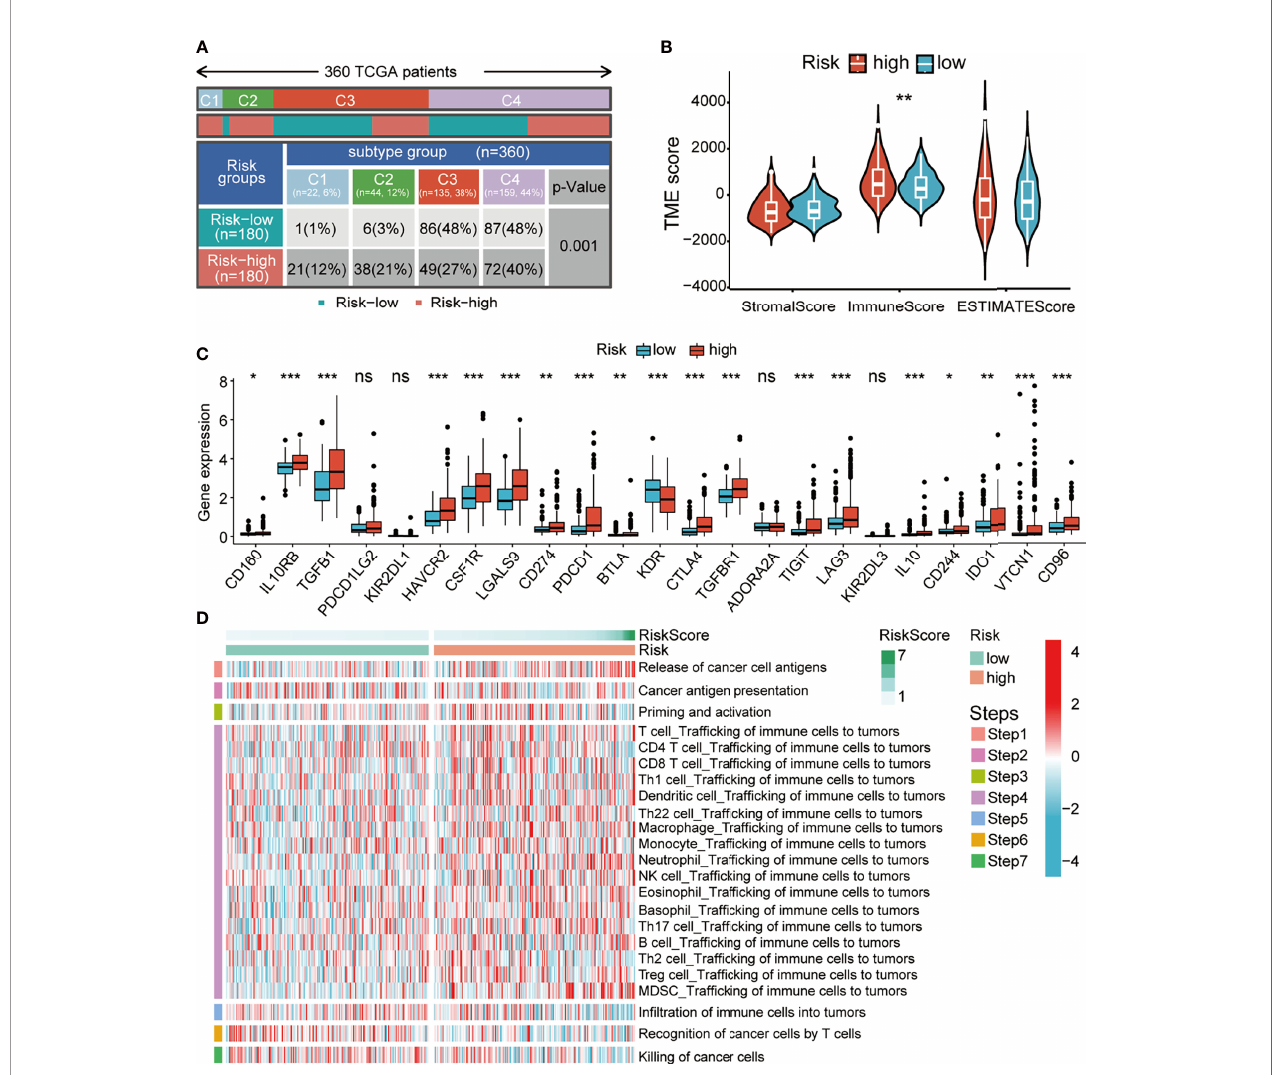
FIGURE 8 | Relationship between the risk score and altered immune landscape. (A) Table showing the distribution of HCC immune subtypes between different risk groups. (B) Violin plots showing the score differences of tumor microenvironment between the different risk groups. (C) Boxplots showing the differential expression of immune-suppressive checkpoints between the different risk groups. (D) Heatmap for anticancer immunity cycles pattern. HCC, hepatocellular